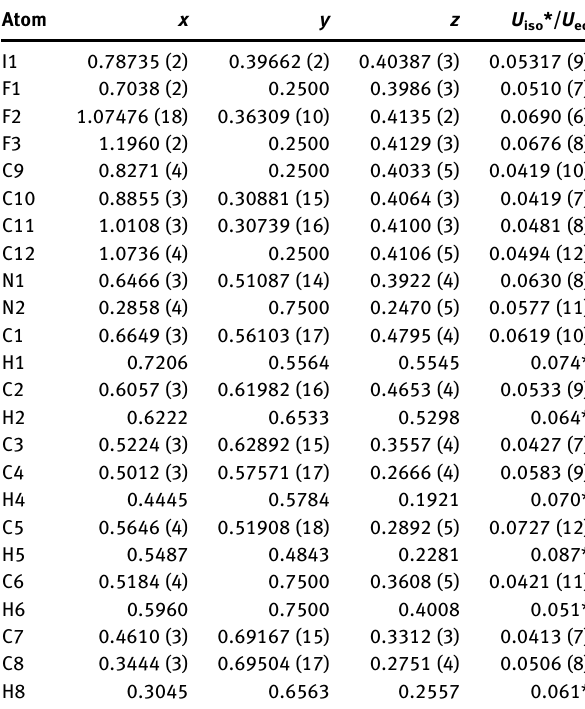
Table  : Fractional atomic coordinates and isotropic or equivalent isotropic displacement parameters (Å 